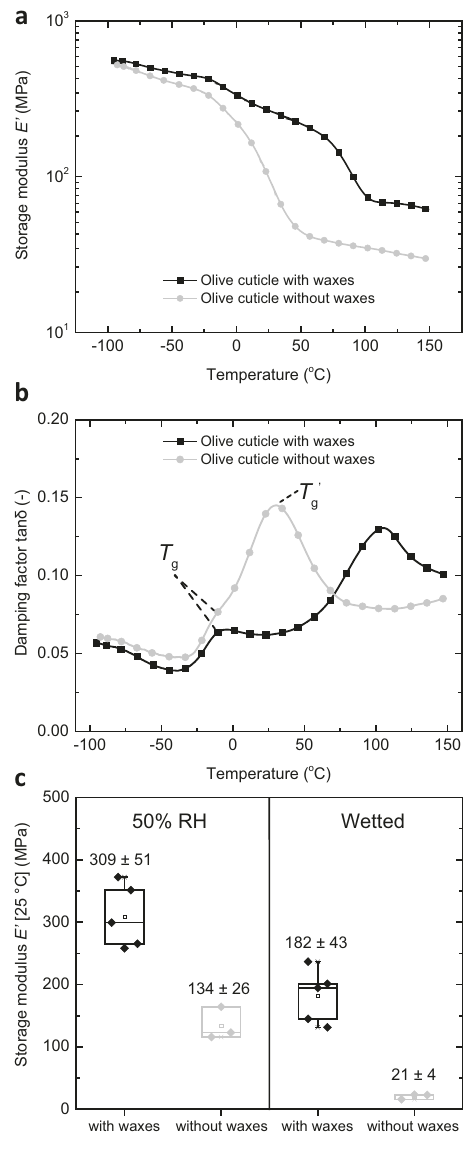
Fig. 5 Dynamic mechanical analysis (DMA) data of olive leaf cuticles with and without waxes. a , b Representative DMA traces of a the storage modulus E ′ and b the damping factor tan δ displaying the cuticular phase transitions. c Box chart displaying the storage modulus E ′ of olive cuticles at 25 °C conditioned at 50% RH and wetted with water showing the plasticizing effect of water. In all boxes, the whiskers extend to min and max values, box edges show 25 – 75 percentiles, center line represents median, and hollow square represents mean. Reported values are the mean ± s.d. of paired measurements at ambient and wet conditions ( n = 5 olive with waxes; n = 3 olive without waxes). Note that the data were analyzed using the overall average thickness that is “ in fl ated ” by the protruding trichomes; as a result, the reported storage modulus E ′ values are systematically underestimated by a factor of ca. 2 – 3 (see also “ DMA measurements ”